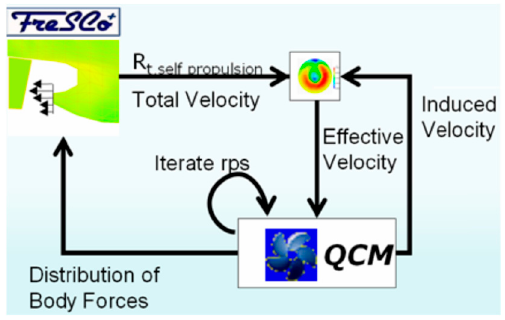
Figure 2. Numerical self-propulsion test scheme by FreSCo + and